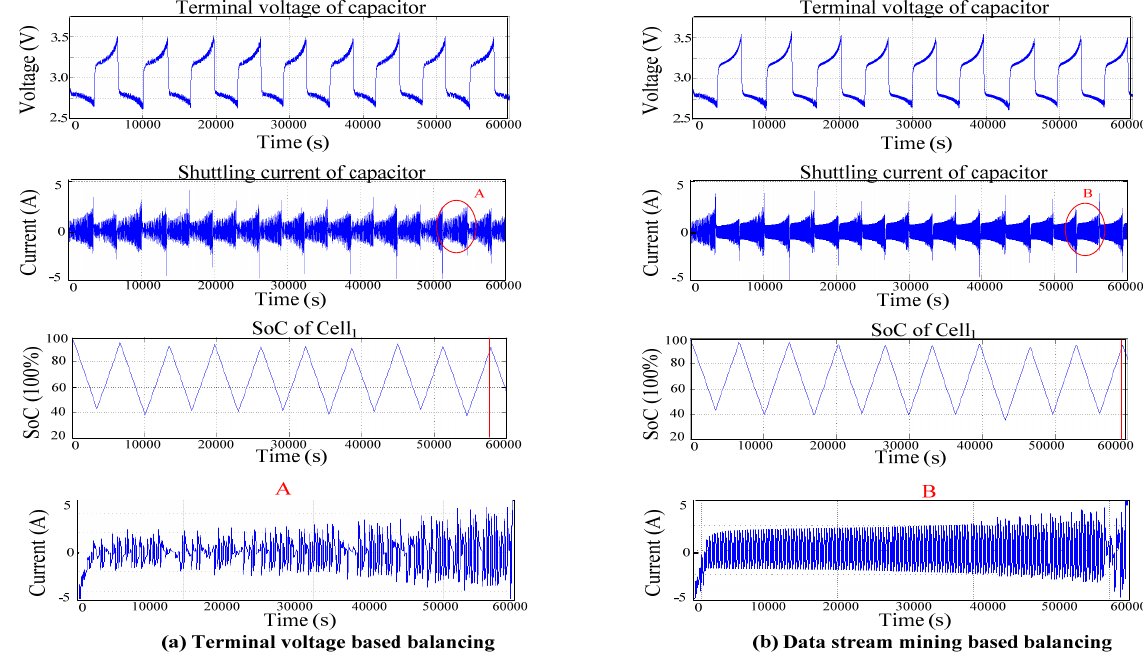
Figure 13. Comparisons of difference balancing strategies: ( a ) TV-BS and ( b )